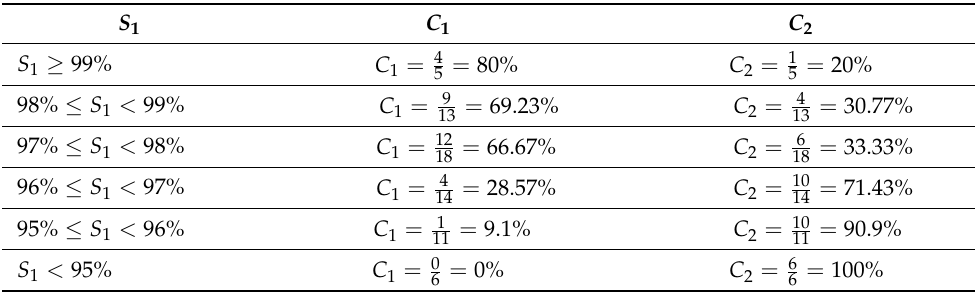
Table 4. Probability of potential energy weighting to velocity–energy ratio.